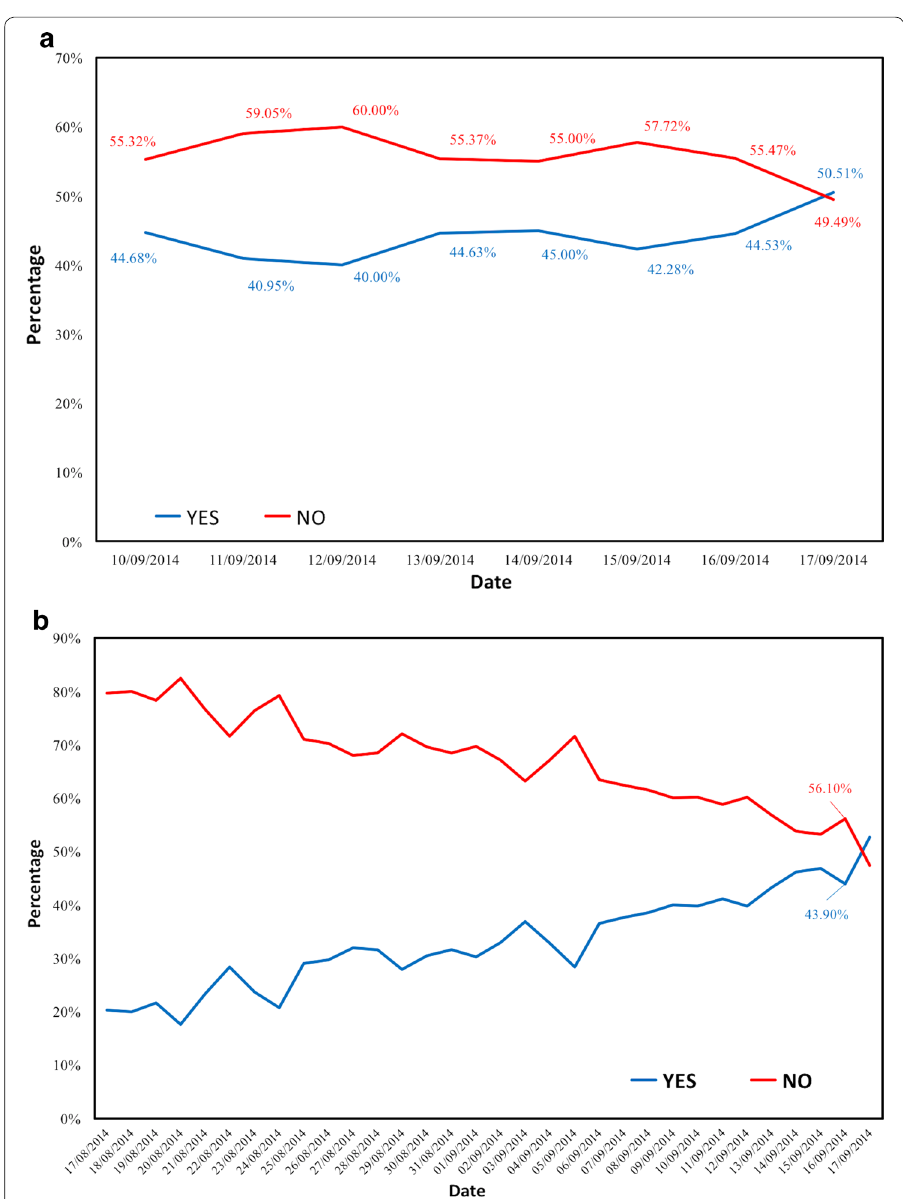
Fig. 1 Percentized Hits for YES and NO in Scotland from ( a ) August 17th to September 17th 2014 and ( b ) from September 10th to September 17th